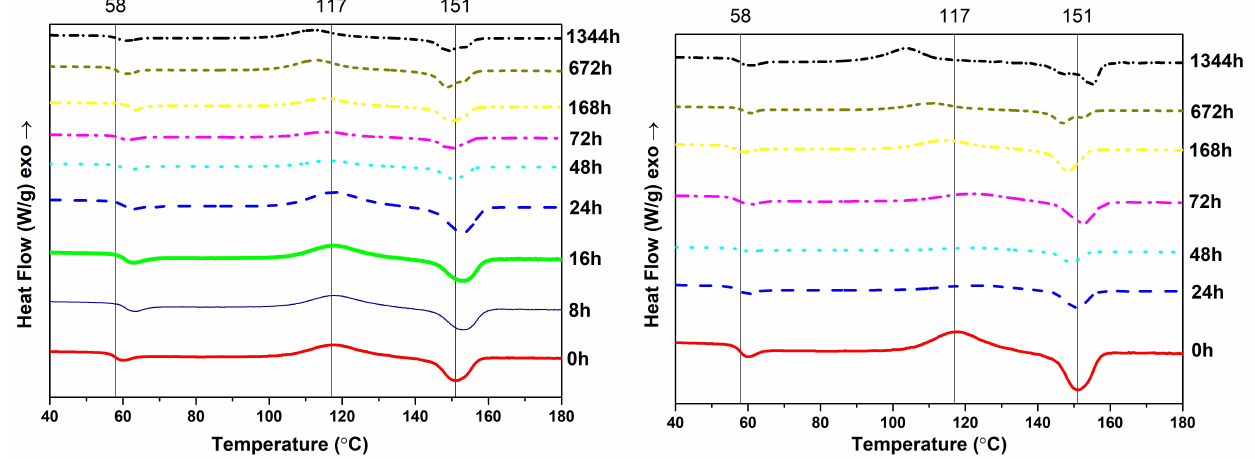
Figure 2. DSC test of PLA specimens after thermal aging ( left ) and hydrothermal aging ( right ). The lines at 58, 117, and 151 ◦ C correspond to T g , T c , and T m of unaged PLA specimens, respectively. The graphs are shifted in the Y-axis to better compare the peak